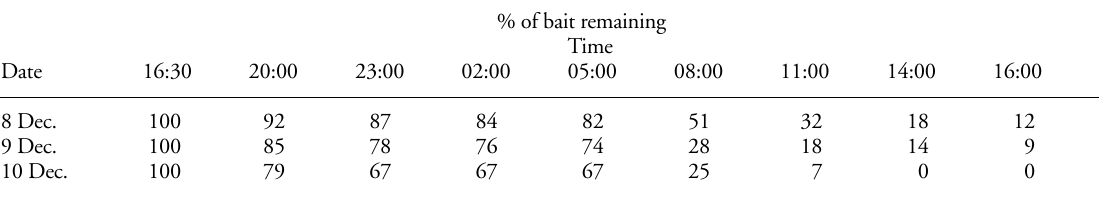
Table 5. Diurnal bait removed dusk to dusk over 3 successive days in December.